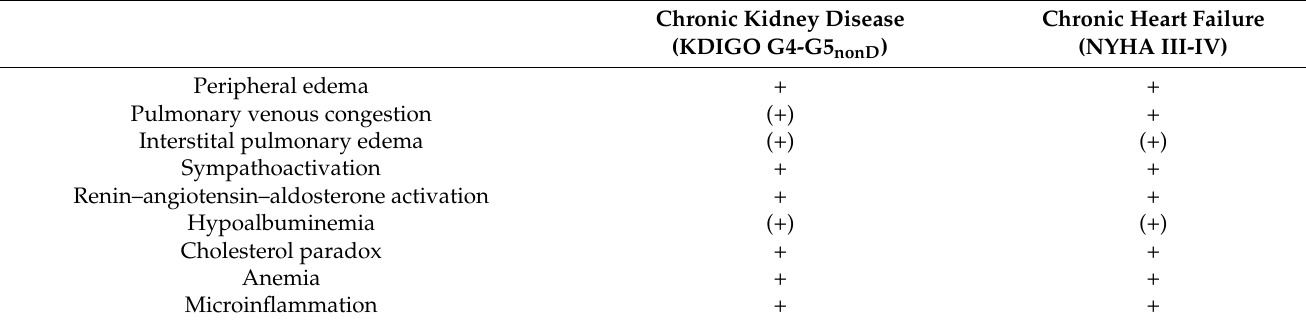
Table 1. Clinical characteristics of chronic kidney disease and chronic heart failure. Chronic Kidney Disease Chronic Heart (KDIGO G4-G5 nonD )